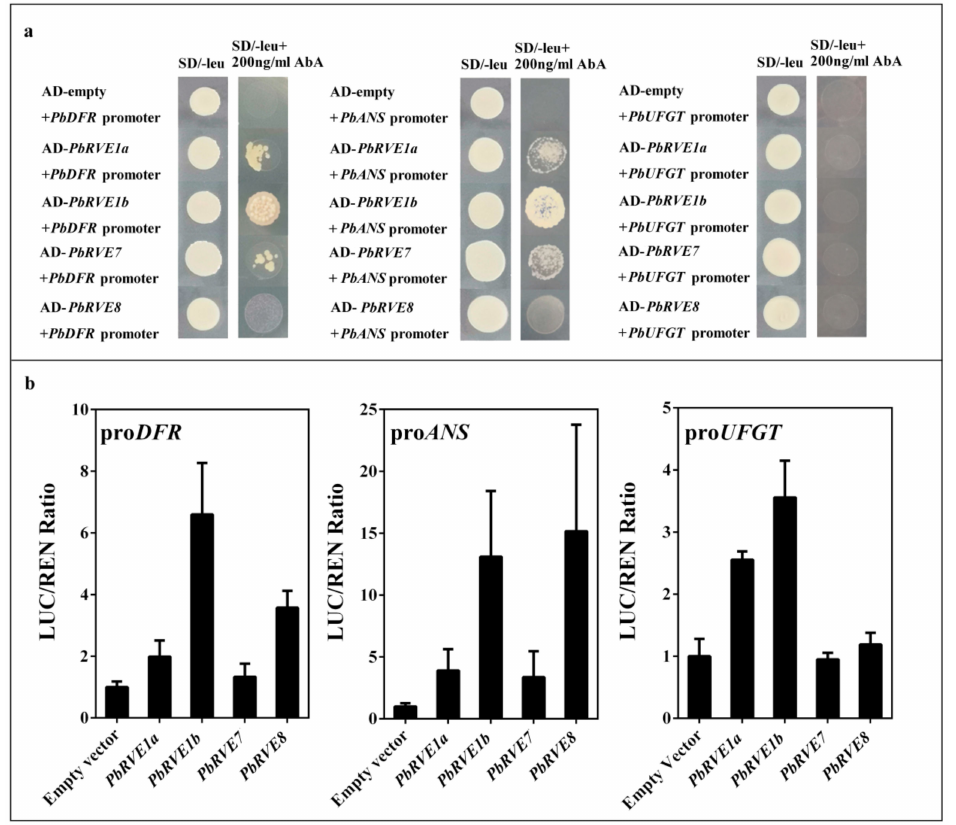
Figure 5. ALBG promoters are bound and stimulated by PbRVE s. ( a ) Yeast one-hybrid assays of PbRVE s with the PbDFR , PbANS and PbUFGT promoters. ( b ) Validation of the activation e ff ects of PbRVE s on the PbDFR , PbANS and PbUFGT promoters using a dual-luciferase assay in Nicotiana benthamiana leaves. The relative promoter activity is represented by the expression ratio of the structural luciferase ( LUC ) gene to the 35S Renilla ( REN ) gene. The ratio was further standardized based on the LUC / REN value of the empty vector. Results represent the means of five biological replicates. All significant di ff erences are based on comparisons with the control. Error bars show the SEs of the means ( n =